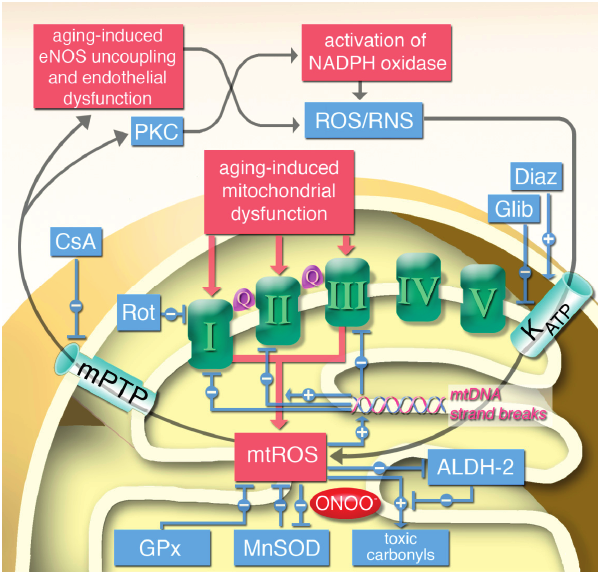
Figure 7. Hypothetic scheme of aging-induced vascular dysfunction and the role of mitochondria in this process. Aging-induced mitochondrial dysfunction triggers mitochondrial reactive oxygen species (mtROS) formation from respiratory complexes I, II, and III (Q = ubiquinone), whereas respiratory complexes IV and V were not reported to contribute to mtROS formation directly. Break-down of mtROS is catalyzed by glutathione peroxidase (GPx, for H 2 O 2 ) or manganese superoxide dismutase (MnSOD), the latter is in turn inhibited by mitochondrial peroxynitrite (ONOO − ) formation. mtROS increase the levels of toxic aldehydes and inhibit the mitochondrial aldehyde dehydrogenase (ALDH-2), the detoxifying enzyme of those aldehydes. Increase in mtROS and toxic aldehydes also leads to mtDNA strand breaks which leads to augmented dysfunction in respiratory chain complexes and further increase in mtROS since mtDNA encodes mainly for those respiratory